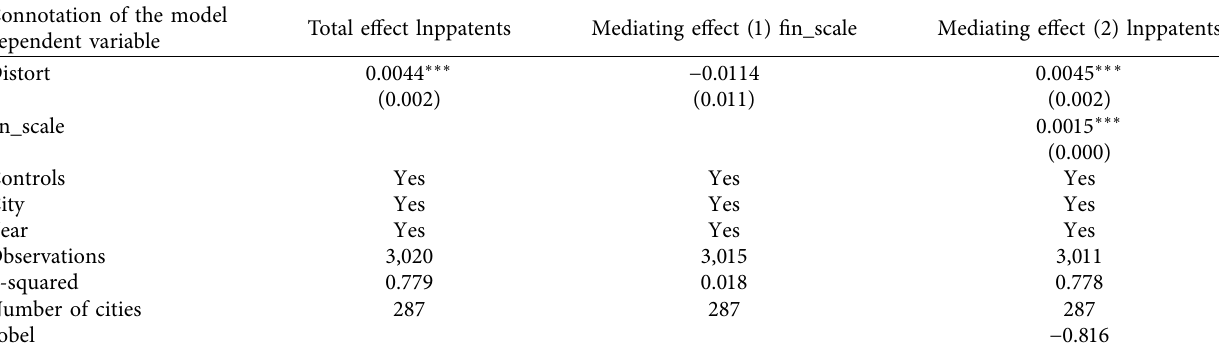
Table 7: Results of financial scale mediating effect test.